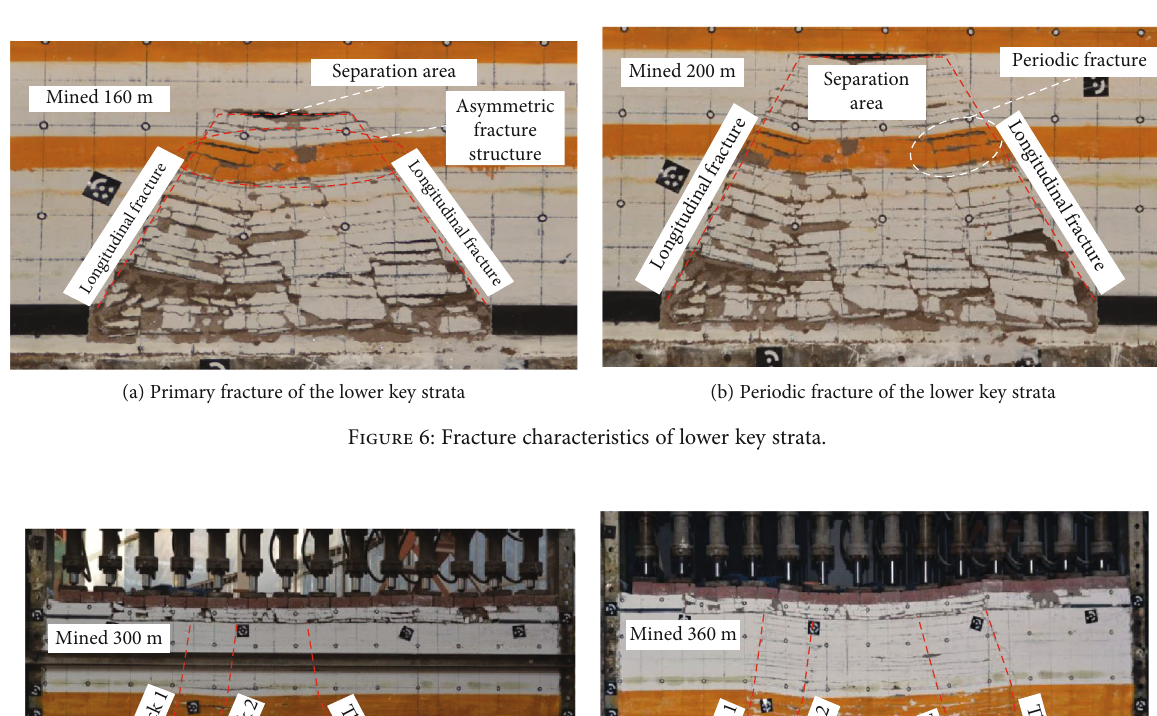
Figure 5: Simultaneous fracture of key strata and overburden strata.